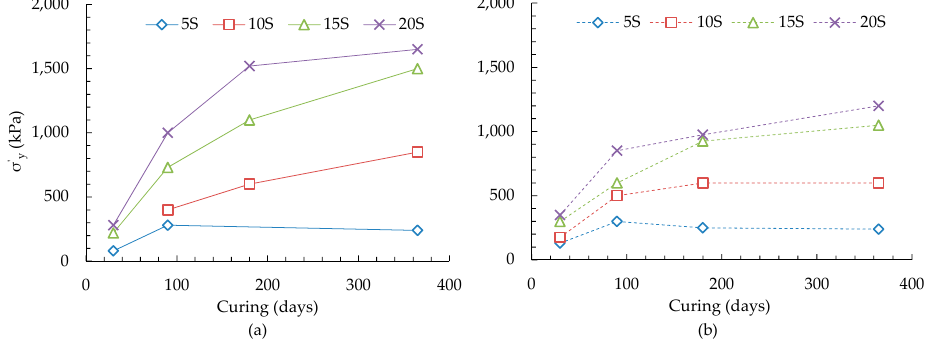
Figure 2. Variations of yield stresses with curing and slag contents for alkali-activated slag treated ( a ) ASS and ( b ) ASS containing 4 wt % additional pyrite.